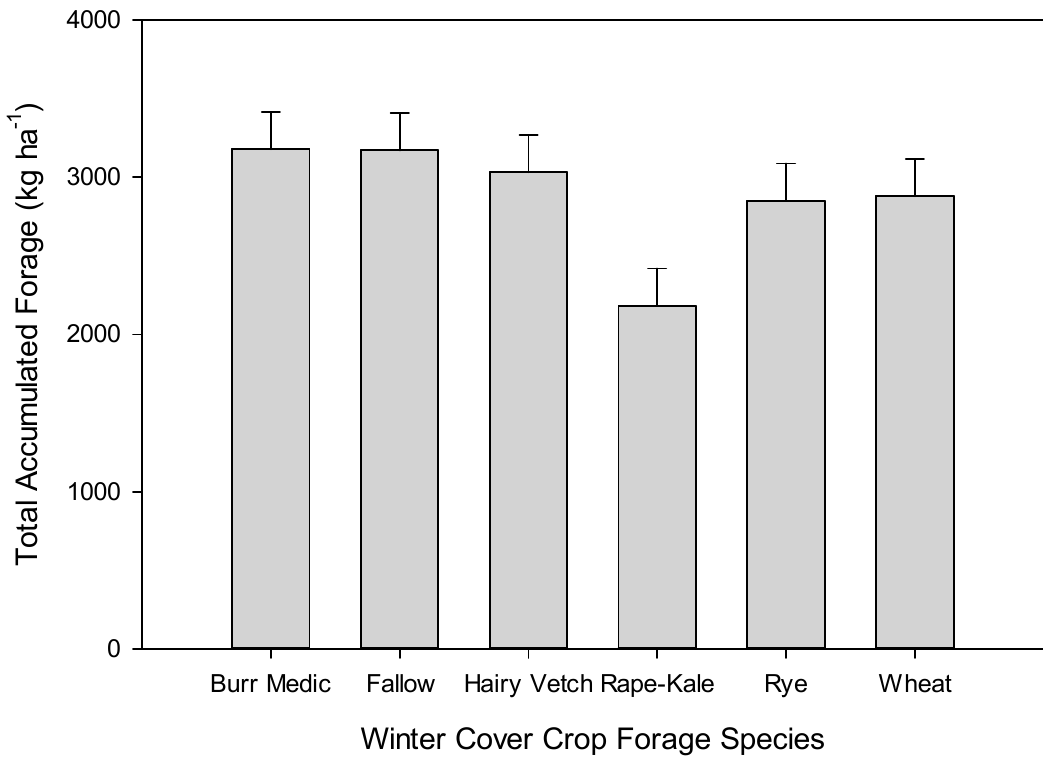
Figure 4. Total accumulated forage produced by teff following winter cover crops in Year 1. Data are averaged over blocks and irrigation treatments. Data were collected on 23 July and 2 September 2016 ( n = 72). Error bars represent standard error.